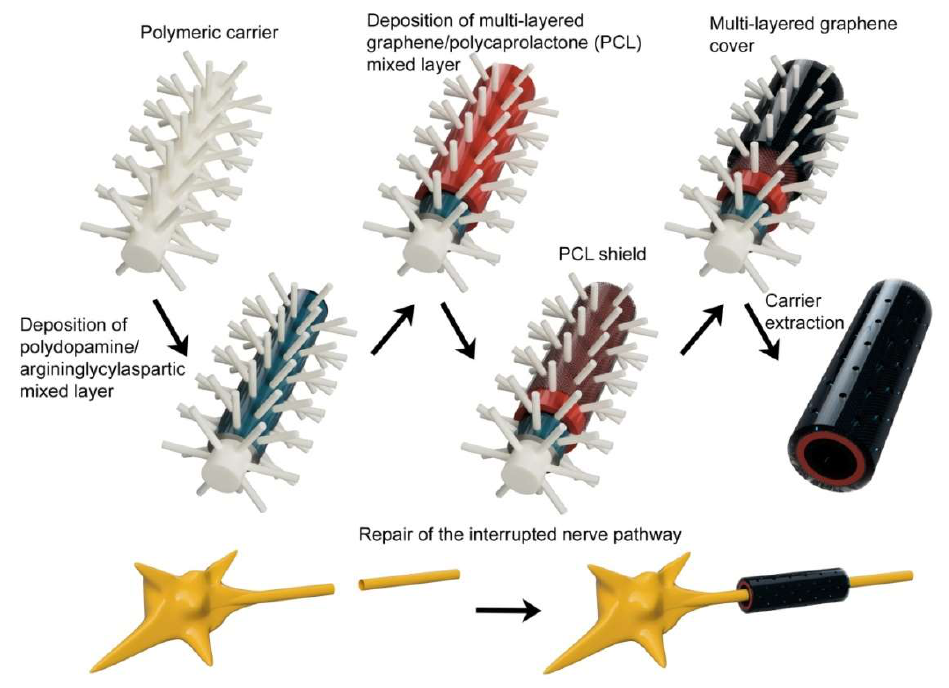
Figure 6. Scheme of replacement of missing part of the neuron with graphene / PCL composite using layer by layer casting method.